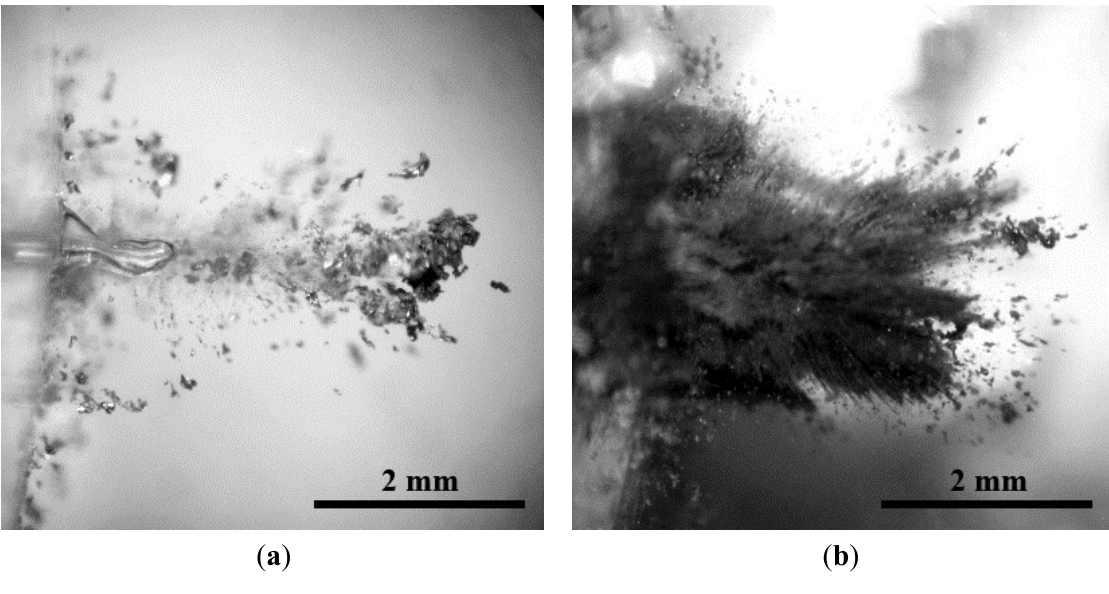
Figure 5. Optical micrographs of the fragments collected in a transparent gel (penetration from left to right) after ejection from 200 µm-thick Al samples subjected to laser shocks of intensity 1.54 TW/cm 2 ( a ) and 7.6 TW/cm 2 ( b ).